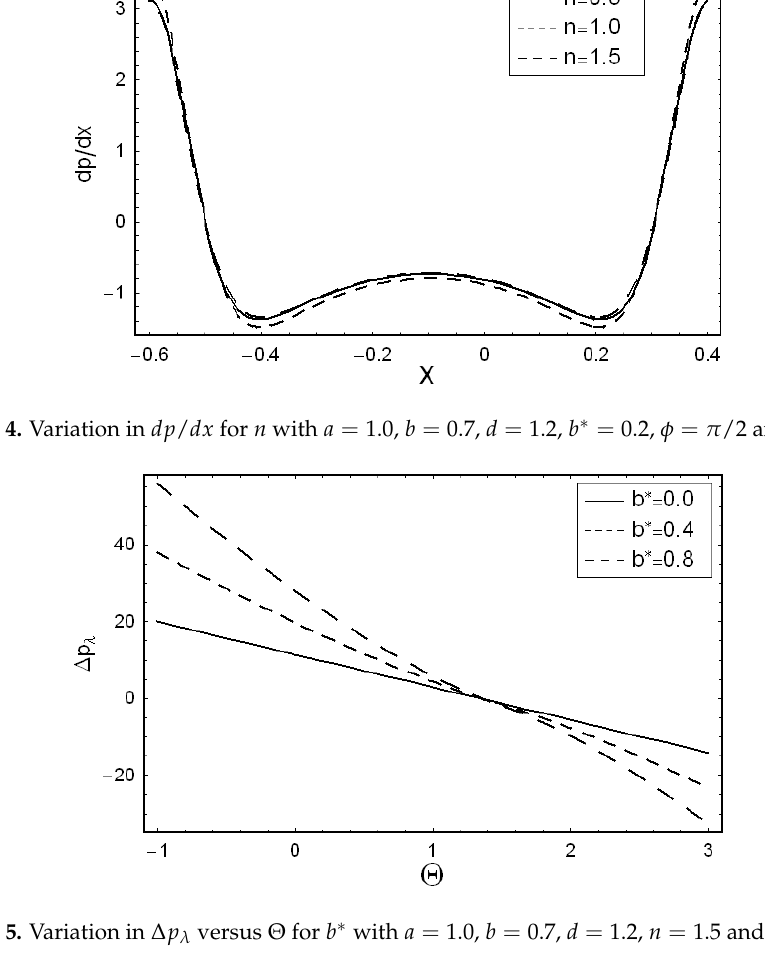
Figure 5. Variation in ∆ p λ versus Θ for b ∗ with a = 1.0, b = 0.7, d = 1.2, n = 1.5 and φ = π /4.